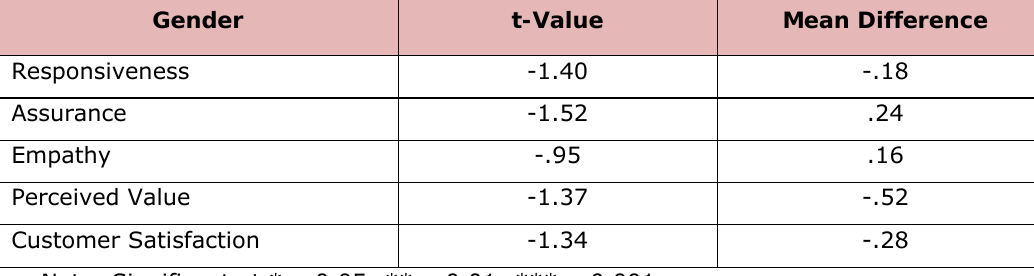
Table 2. “Independent Samples T-Test for the Differences between Gender”.